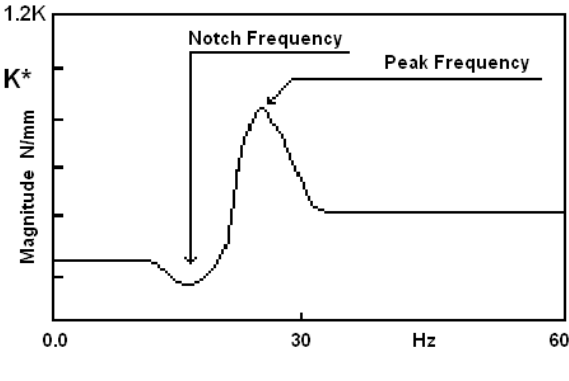
Fig. 5. A typical passive fluid mount dynamic